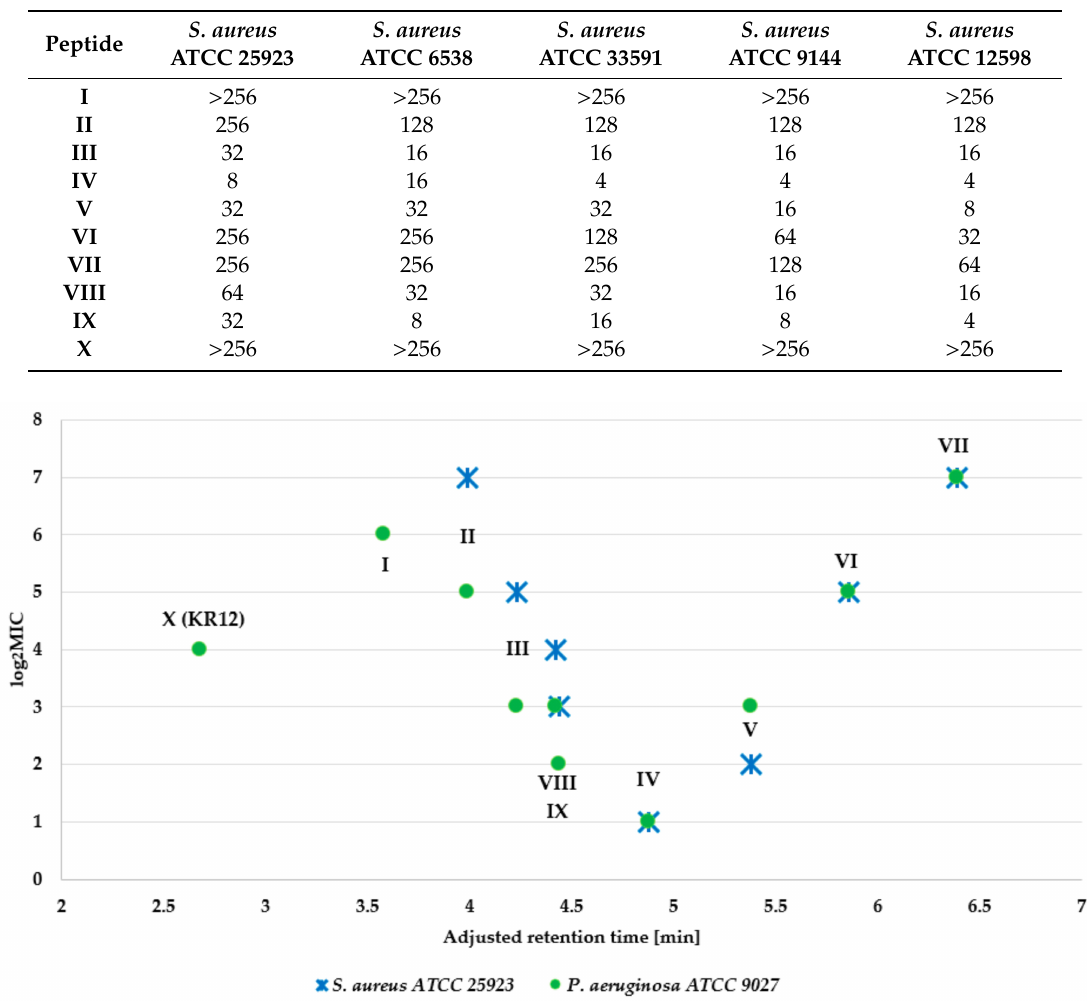
Figure 2. Antimicrobial activity of KR12 amide and its analogs (log 2 MIC) against S. aureus ATCC 25923 and P. aeruginosa ATCC 9027 versus adjusted retention